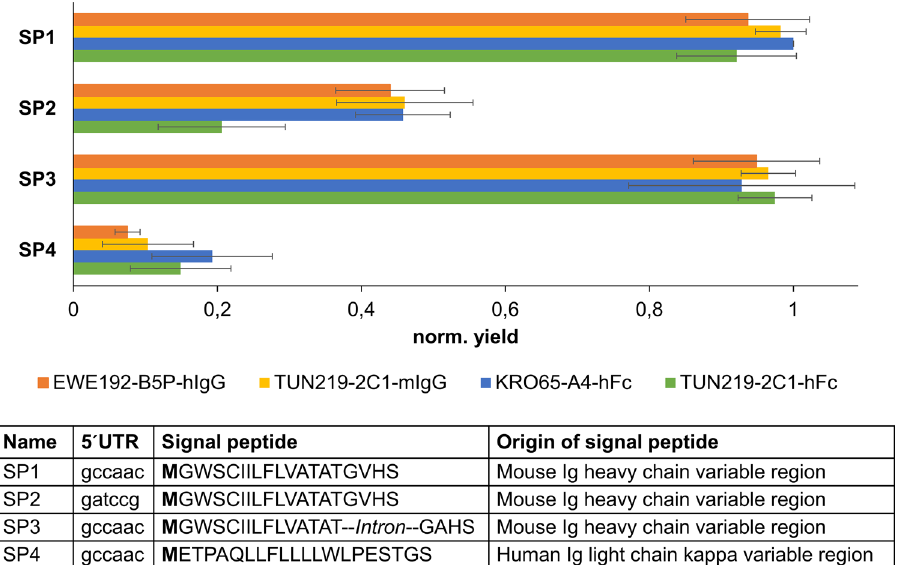
Figure 1. Normalized yield of two different IgG and two different scFv-Fc expressed by the different vectors employing different 5 ′ UTR or signal peptides. The yields were normalized against the respective highest yield obtained with one of the four expression vectors. All experiments were performed four times; standard deviation is